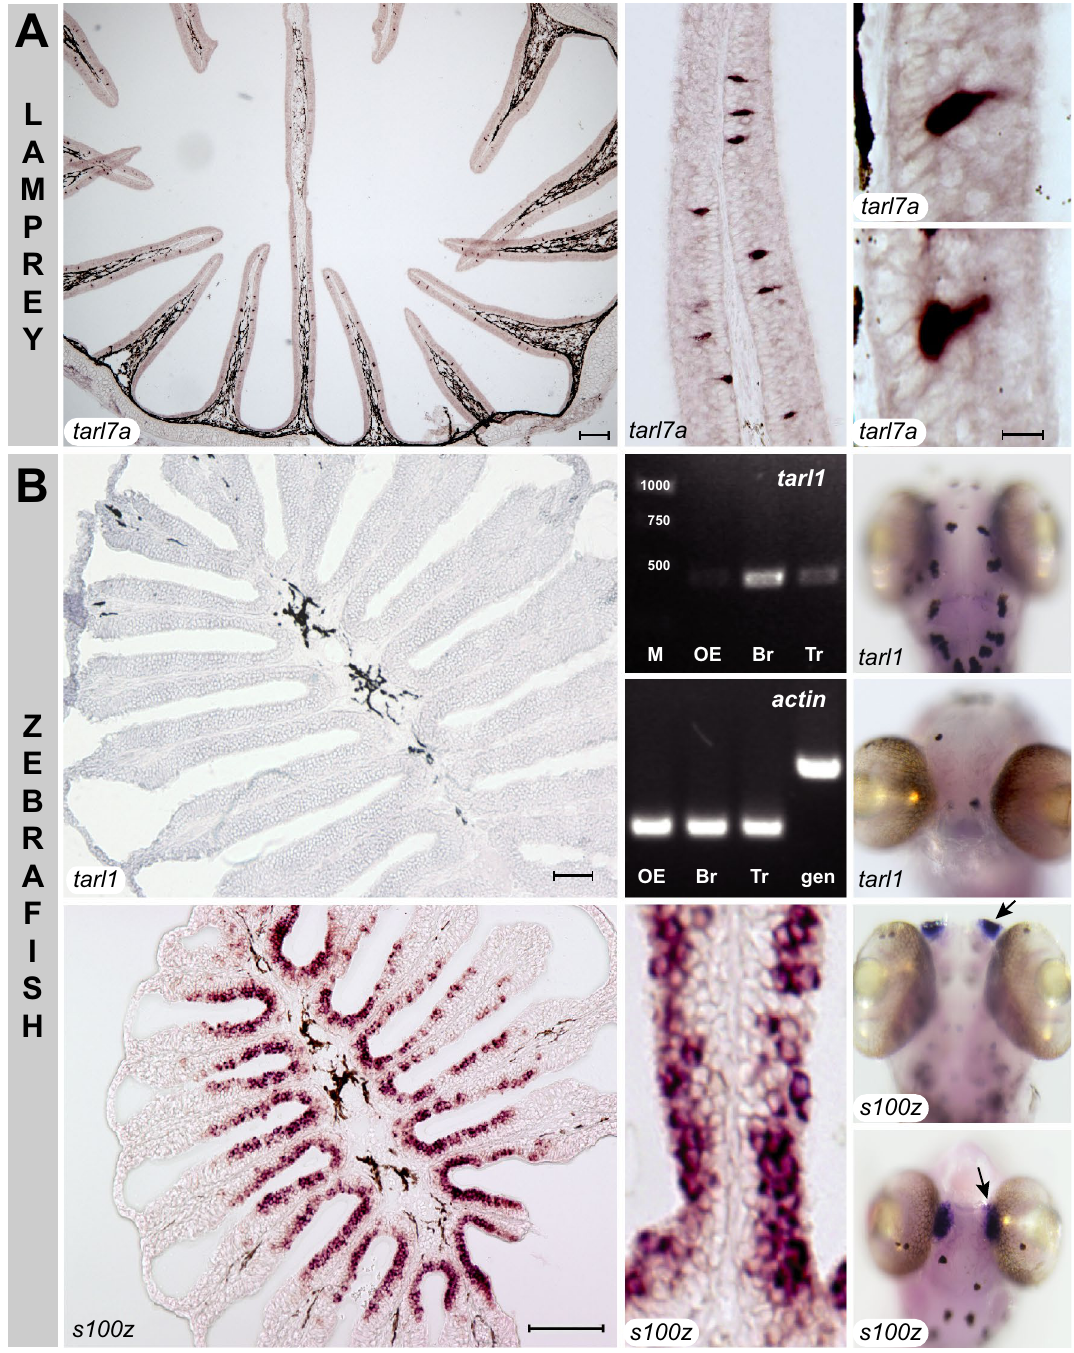
Figure 4. Unlike lamprey tarl, zebrafish tarl is not expressed in the nose. ( A ) Lamprey ( Lampetra fluviatilis ) tarl7a probe was used to perform chromogenic in situ hybridization of horizontal cryostat sections of olfactory epithelia. Scale bars: left panel 200 μm, middle panel 50 μm and right panels 10 μm. Note expression in sparse cells within the olfactory lamellae, characteristic for olfactory receptors. ( B ) Middle column, top panel, RT-PCR for Dr- tarl1 with primer pair 1 (see Materials and Methods) shows extremely faint signal in the OE, a strong signal in the brain (Br) and moderate expression in the trunk (Tr). Dr- tarl1 primer pair 2 gave same results (data not shown); M, marker, numbers refer to bp. Middle panel, beta-actin was used as control, and shows equal loading in all tissues as well as absence of genomic DNA in the cDNA preparation (gen, genomic DNA). Both in situ hybridization of horizontal cryostat sections of olfactory epithelia (left panel, scale bar 50 μm) and whole mount in situ hybridization of 5 dpf zebrafish larvae (top right panel, dorsal view; bottom panel, frontal view) show absence of tarl1 expression in the nose. In situ hybridization results shown are for probe 1 corresponding to primer pair 1 (see Materials and Methods). All but one panel have been modified from the PhD thesis of one author 43 . Bottom row, as a positive control, S100z expression is shown in the adult nose (left and middle panel, scale bars 100 and 20 μm, respectively) and in 5 dpf larvae, same orientation as for tarl1 expression. The nose (black arrows) is visible as two anterior bluish spots (top panel, dorsal view) and medially adjacent to the eyes (bottom panel, frontal